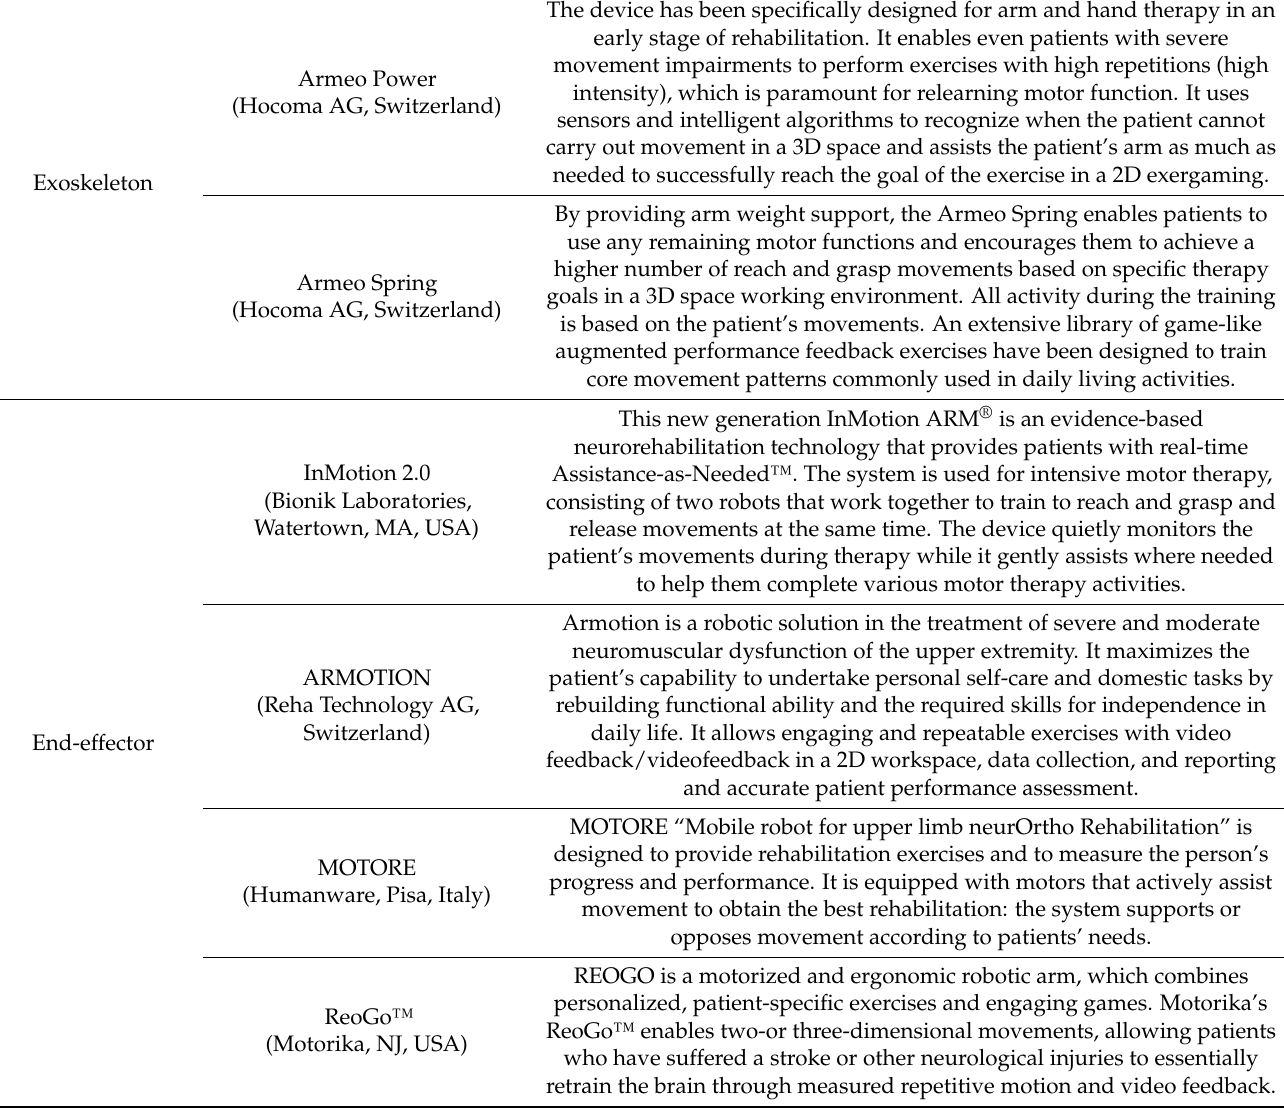
Table 1. Summary of the features of the devices employed (device classification and brand name) for upper limb rehabilitation.